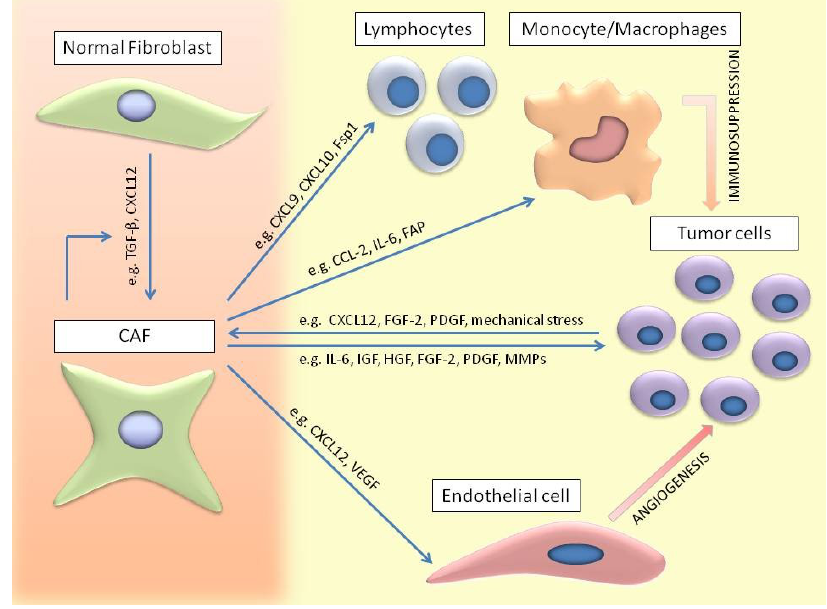
Figure 1. Schematic overview of CAFs involvement in tumor growth and progression. Local fibroblasts, generally considered as the major source of CAFs, can be stimulated by autocrine/paracrine TGF-β and CXCL12. CAFs are able to induce tumor progression by direct and indirect effects. They secrete growth factors (e.g., IL-6, IGF, HGF, FGF-2, PDGF) and enzymes like matrix metalloproteinases (MMPs) which are able to induce tumor progression and metastasis. Importantly, they modify the surrounding tumor microenvironment by actions on endothelial cells and immune cells. Secretion of pro-angiogenic factors CXC12, VEGF, FGF, IL8/CXCL8 and PDGF-C by CAFs recruit endothelial cells and their precursors in order to stimulate tumor angiogenesis. Furthermore, CCL-2, IL-6, FAP, IL-4, hyaluronan and IL-8 secretion by CAFs played a role in monocyte/macrophage recruitment, differentiation and M2 polarization resulting in immunosuppression. CXCL9, CXCL10, CXCL12 and Fsp1 were mentioned to promote lymphocyte recruitment and induce immunosuppression by an increase in Th2, Th17 and regulatory T-cells. All these effects on neighboring cells lead to increased tumor cell proliferation. In turn, tumor cells secrete growth factors and induce mechanical stress causing CAFs